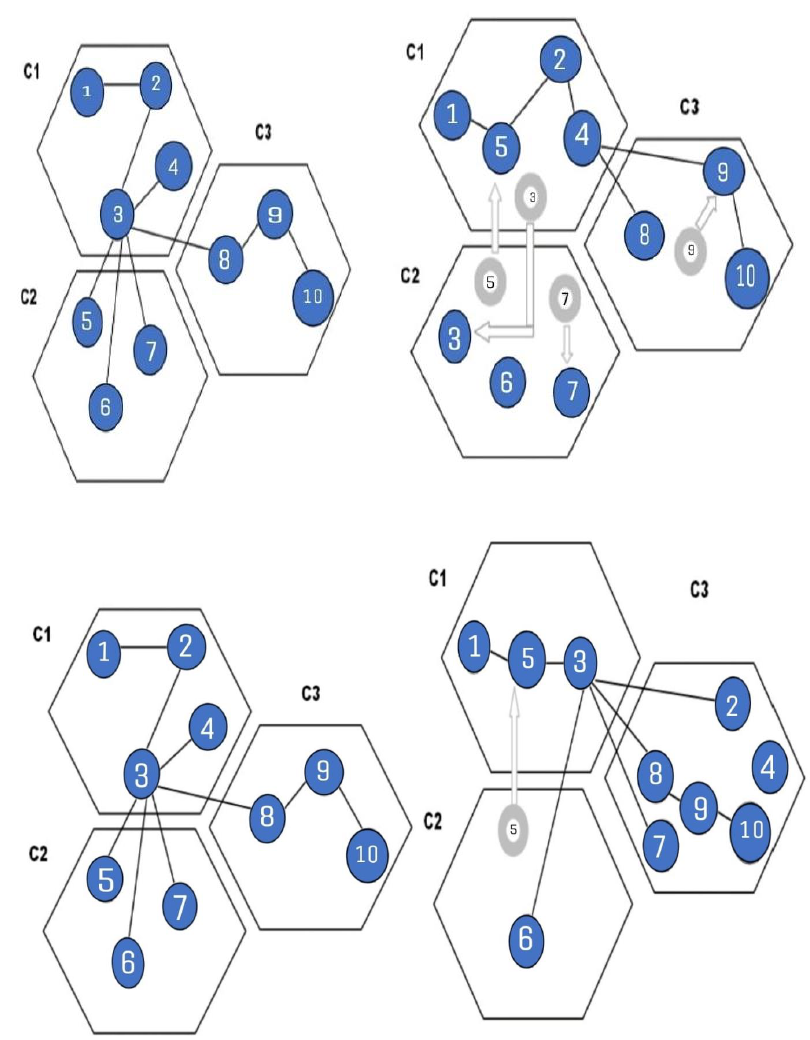
Figure 4. Inter-Cluster Model with Movement of Nodes.